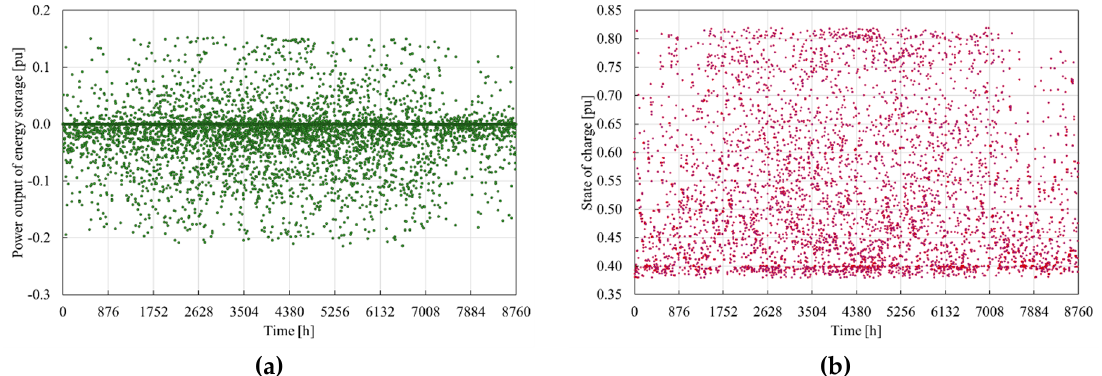
Figure 11. The yearly profiles of ( a ) the power generated by PV system P PV , ( b ) the power at the point of common coupling P PCC and power exchanged with the electricity balancing market P EBM (all related to PV system rated power). Own illustration based on PV GIS data on solar irradiation for LINTE^2 location.